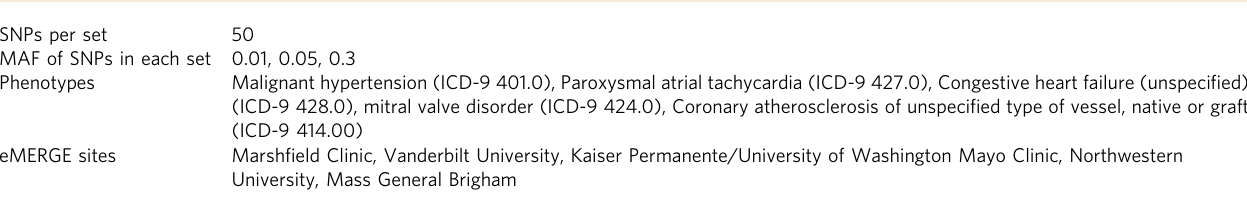
Table 2 Simulation using multiple eMERGE sites.